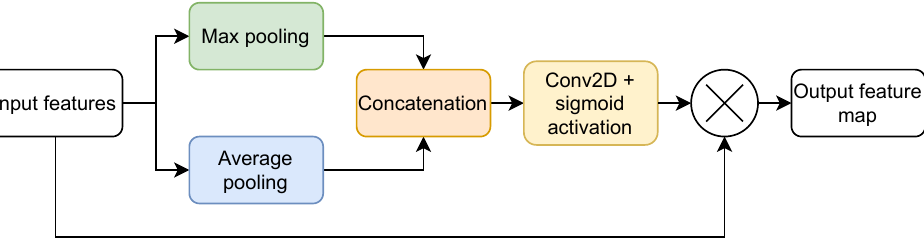
Figure 13. Structure of the SA module employed by Guo et al.